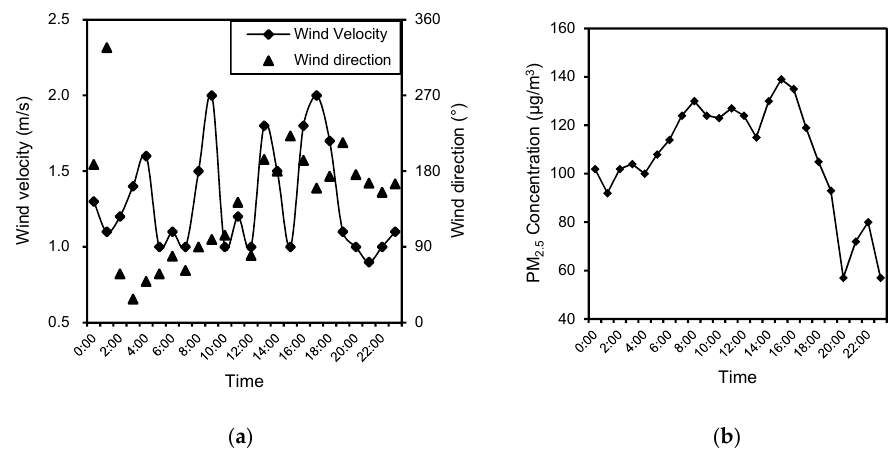
Figure 2. On-site measurements of ( a ) average wind velocity and wind direction by hour and ( b ) average PM 2.5 by hour of P w . Table 1. Vegetation parameter setting in numerical